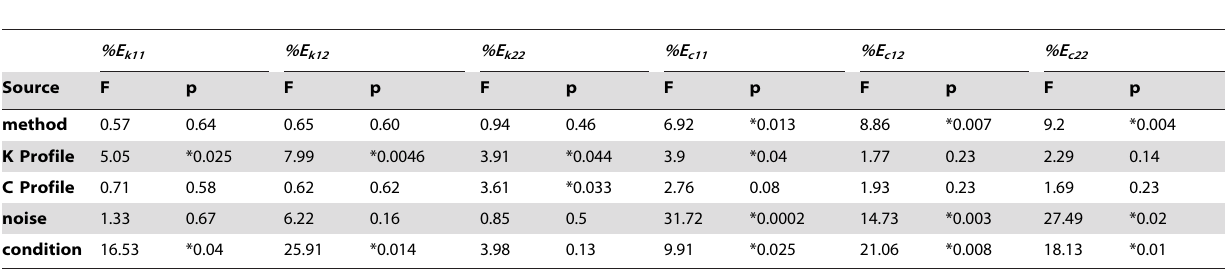
Table 2. Repeated measures ANOVA among estimation methods with stiffness and damping time-profiles as random factors along the interval 2.5–5 s.